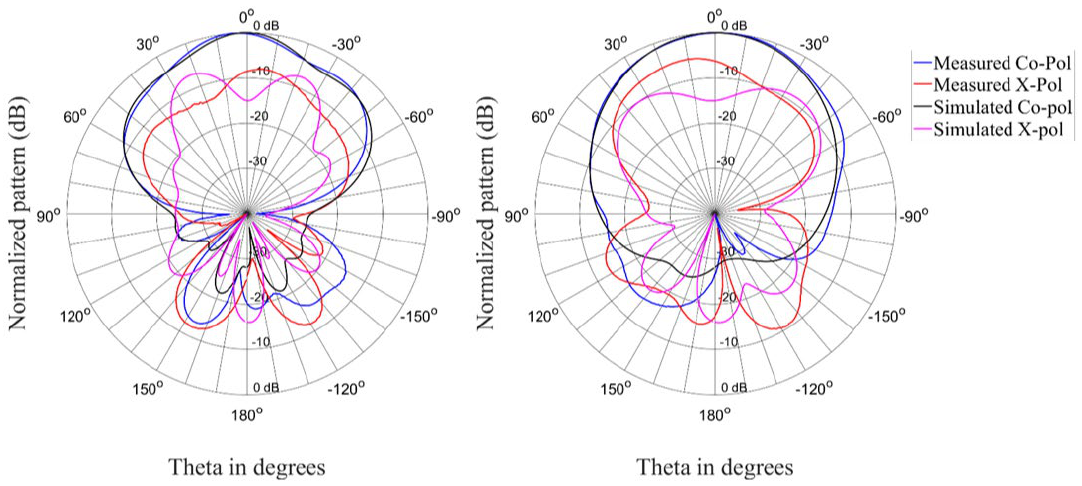
Figure 11. Radiation patterns (Phi = 0° and Phi = 90°) of the antenna in the linear state at 2.45 GHz.